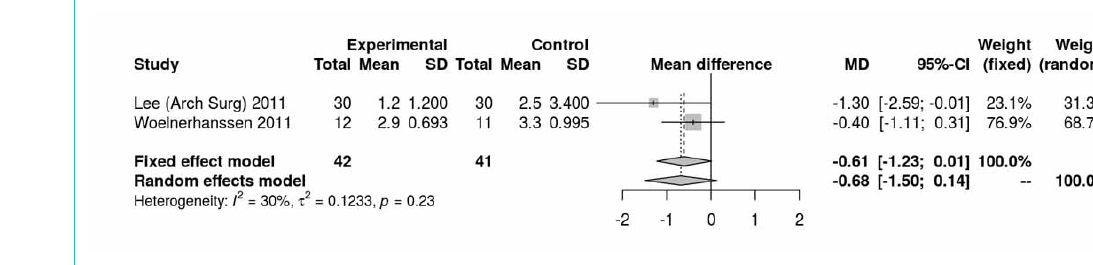
Figure 5e: HOMA index at 12 months without Schauer et al. 2012